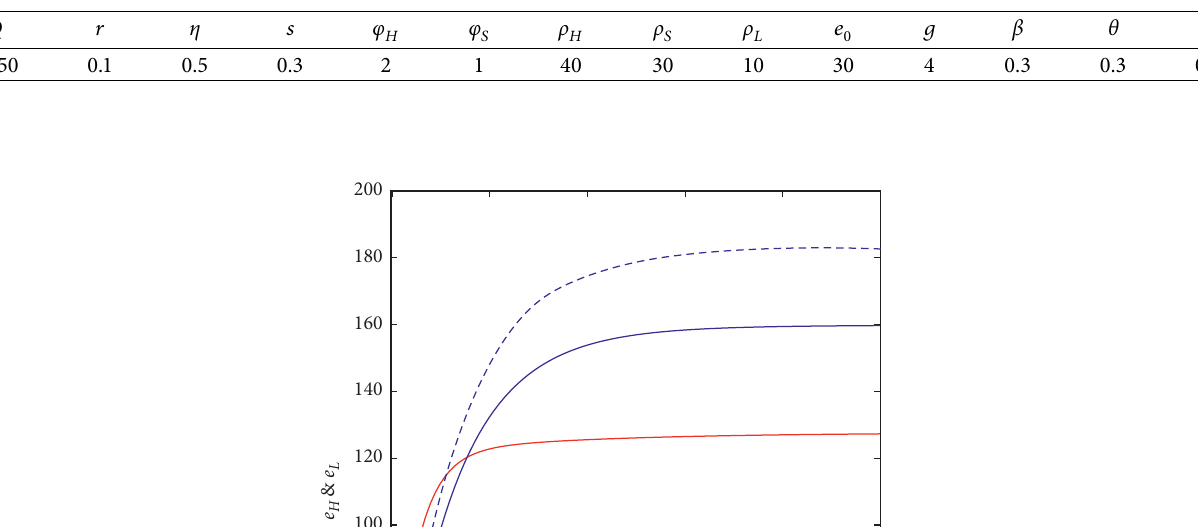
Table 2: Baseline parameter values.